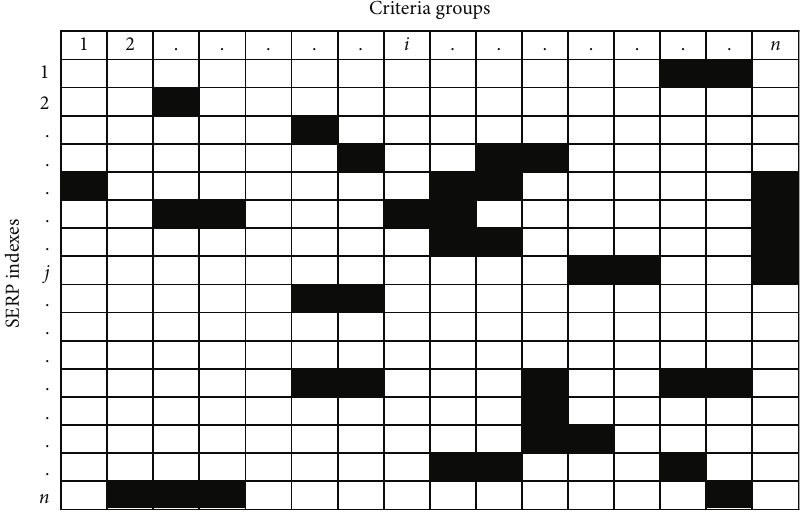
Figure 4: Assignment plan: Hopfield neural network matrix in the state of